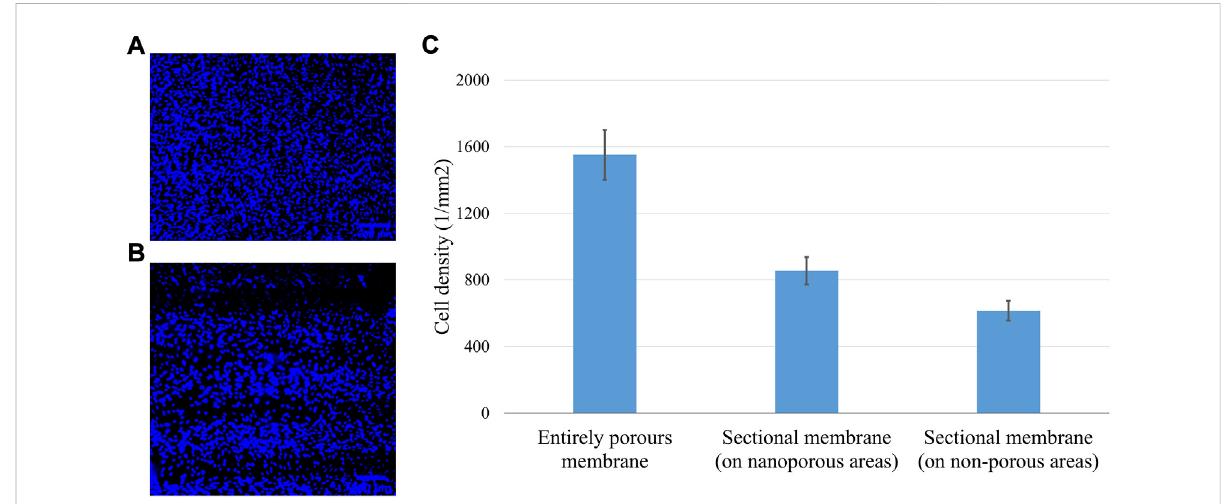
FIGURE 11 Stained nuclei for cell density evaluation on continuous (A) and patterned (B) nanopore distributions. Cell densities (C) obtained with the cell counter fi nder software Fiji (IMAGEJ, National Institutes of Health, Bethesda, MD) show highest values for the membranes with continuous porosity. Data are expressed as mean values ±standard